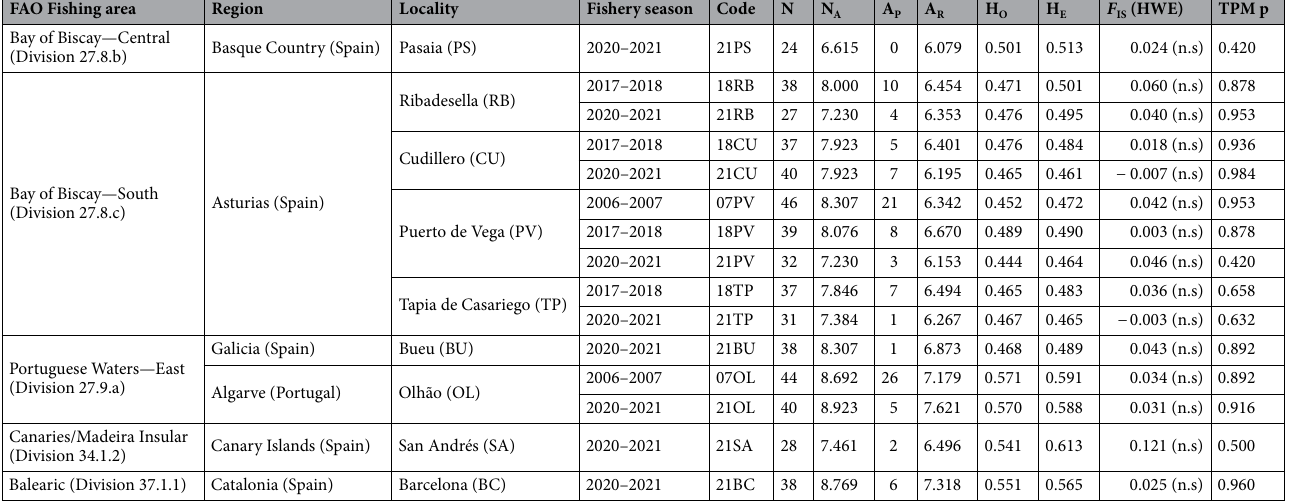
Table 2. Levels of genetic variation after spatial and temporal genetic analyses using microsatellites in O. vulgaris from the Iberian Peninsula and the Canary Islands. N sample sizes, N A Mean number of alleles by locus, A P Private alleles (calculated spatially for the same fishery season), A R Allelic richness for the minimum possible number of diploid individuals per sample, H O observed heterozygosity, H E expected heterozygosity, F IS degree of departure from expected Hardy–Weinberg proportions within samples ( n.s not significant), TPM p Wilcoxon sign test probability under TPM method. *p < 0.05, **p < 0.01, ***p <